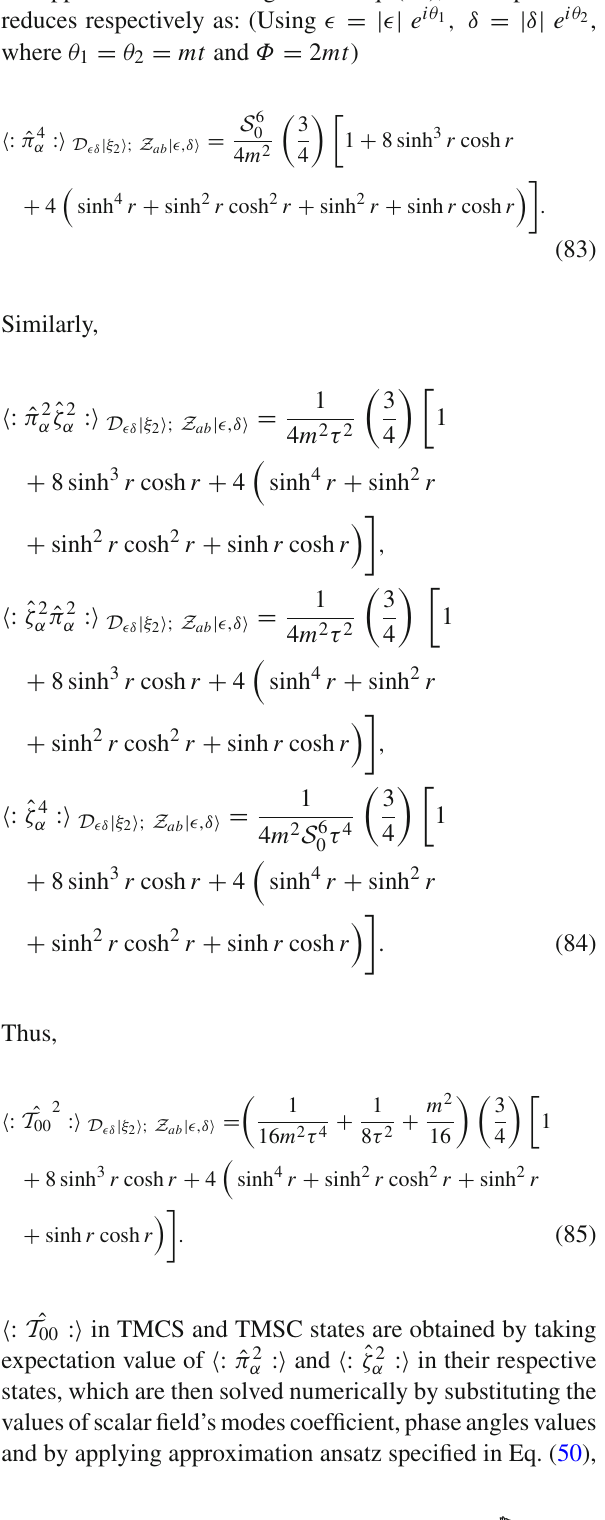
< 1 only 2 (cid:3) o